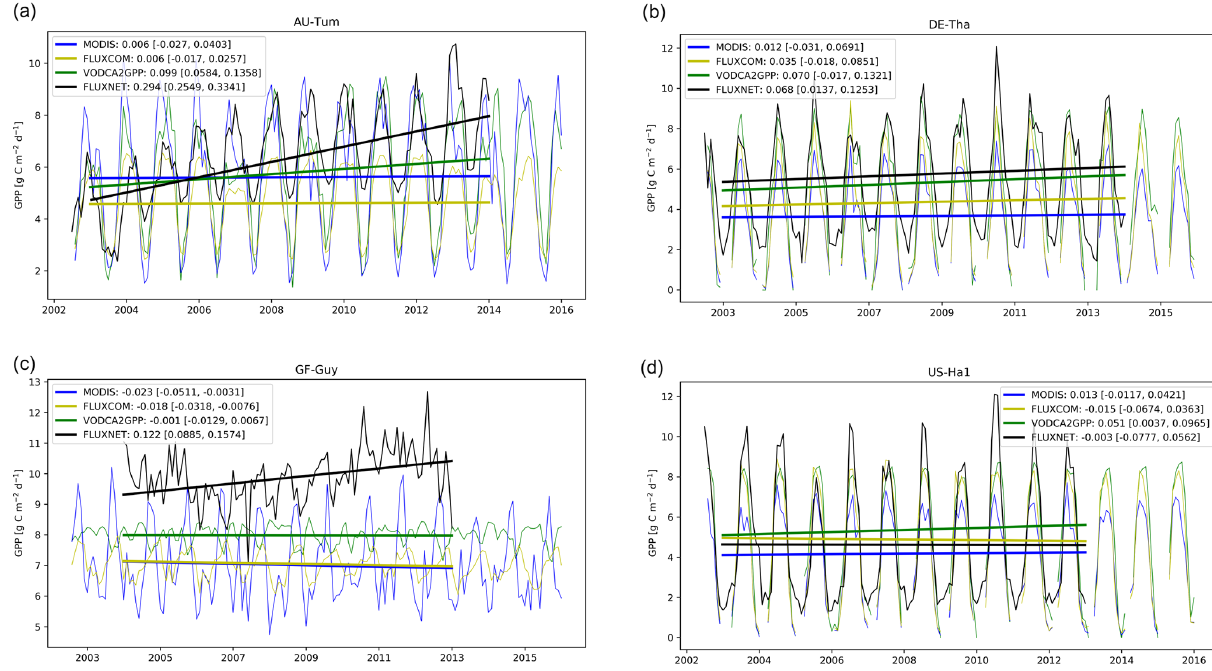
Figure A6. Exemplary collection of time series of in situ FLUXNET GPP together with extracted time series from MODIS, FLUXCOM, and VODCA2GPP. The stations were selected because of their high data availability for their respective land cover. The lines indicate the regression lines as obtained from the Theil–Sen slope estimation for yearly median GPP. The trends are computed for the common observation period with FLUXNET. The slope [gCm − 2 yr − 1 ] is depicted in the legend together with the respective 90% lower and upper confidence intervals. The depicted stations are as follows: (a) AU-Tum – Tumbarumba, Australia; − 35 . 65 ◦ N, 148.15 ◦ E; land cover EBF; (b)